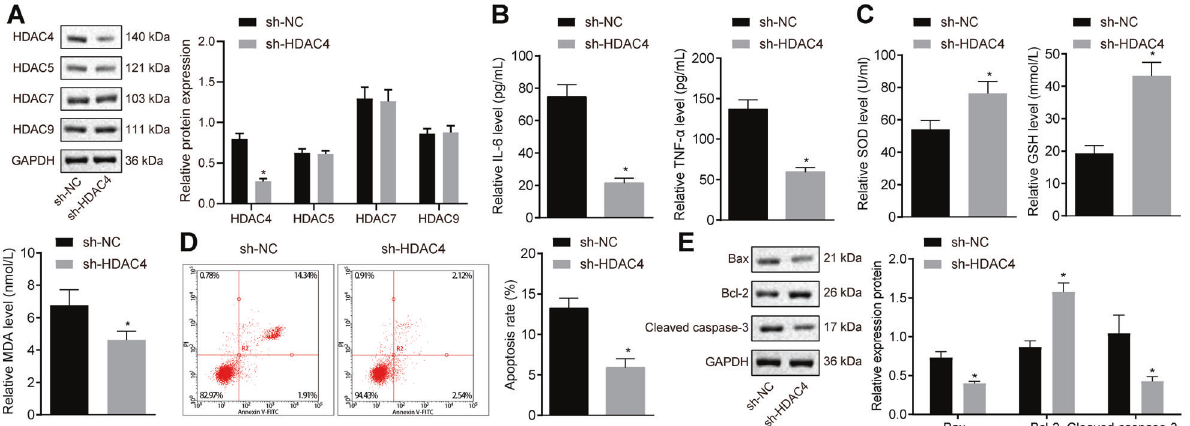
Fig. 2 Silencing of HDAC4 protects cardiomyocytes from IRI in vitro. A HDAC4 silencing ef fi ciency and the expression of HDAC5, HDAC7, and HDAC9 in cardiomyocytes evaluated by western blot analysis, normalized to GAPDH. B The levels of in fl ammatory factors (IL-6 and TNF- α ) in cardiomyocytes determined by ELISA. C The levels of SOD, GSH, and MDA in the cardiomyocytes. D Apoptosis of cardiomyocytes detected by fl ow cytometry. E The expression of Bax, Bcl-2, and cleaved Caspase-3 protein in cardiomyocytes determined by western blot analysis, normalized to GAPDH. * p < 0.05 vs. the cardiomyocytes transfected with sh-NC. Data were all measurement data and expressed as mean ± standard derivation. Comparisons between two groups were analyzed by unpaired t- test. The experiment was conducted three times